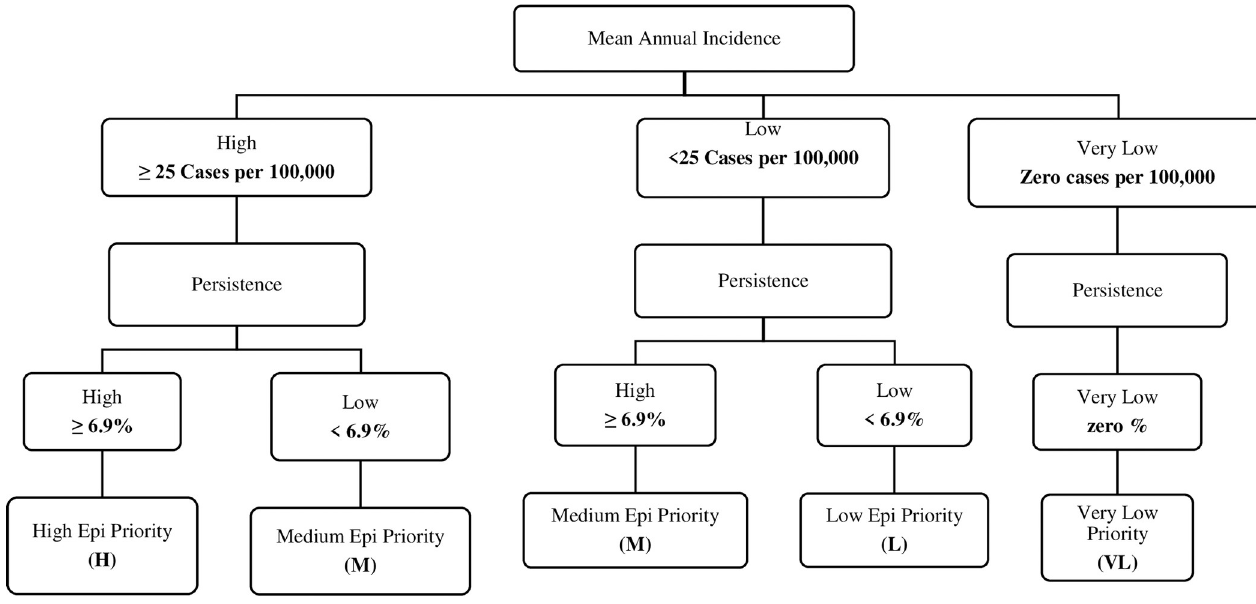
Fig 1. Prioritization by Epidemiological